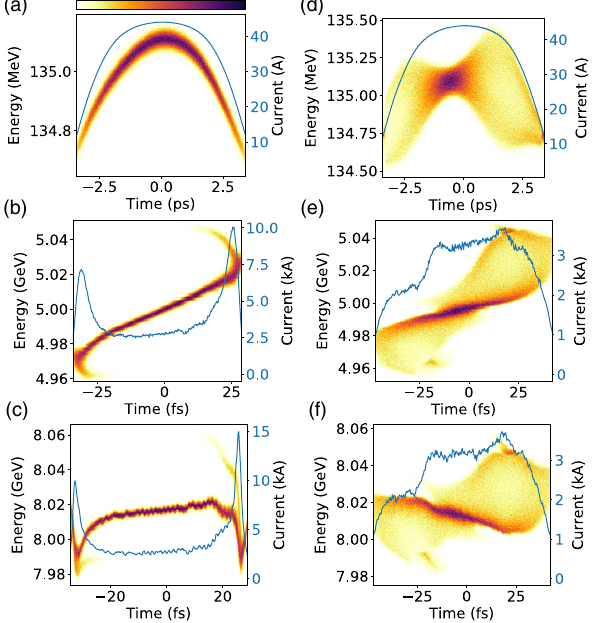
FIG. 11. Elegant simulations (a – c) without and (d – f) with laser heater horn collimation for the LCLS-II superconducting linac. Figures (a) and (d) show the longitudinal phase space after the laser heater with and without the pairs of Gaussian pulses. Figures (b) and (e) show the beam after the second bunch compressor. Figures (c) and (f) show the beam at the entrance of the soft x-ray undulators. The color bar above (a) shows the relative density for each plot. See Table V.